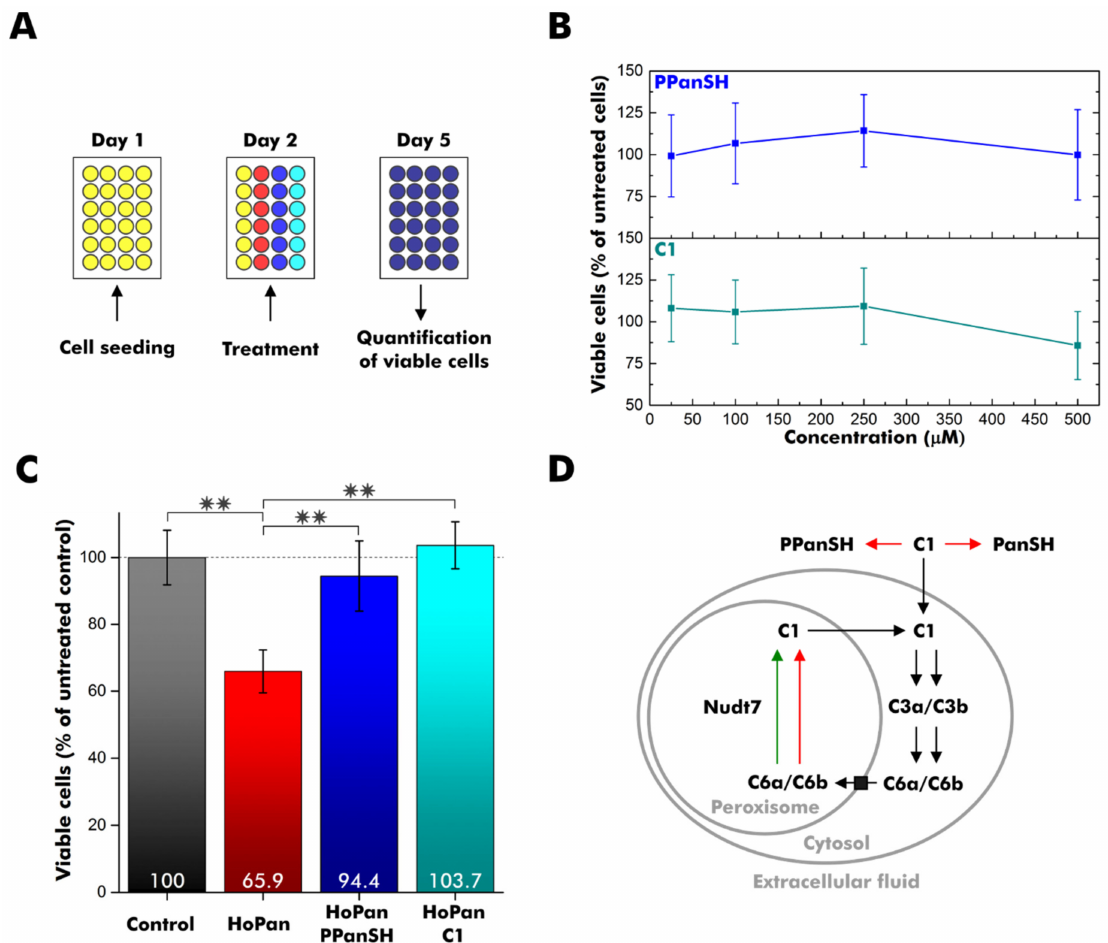
Figure 3. Supplementation of cell cultures with C1. ( A ) Experiment design overview. HEK 293T cells were seeded on day 1 and treated with calcium hopantenate (HoPan), PPanSH, C1, or a combination on day 2. Viable cells were quantified by a colorimetric cell proliferation assay on day 5. ( B ) Percentage of viable cells after growth in the presence of varying concentrations of PPanSH or C1 relative to untreated cells. ( C ) Percentage of viable cells after growth in the presence of 500 µ M HoPan, 500 µ M HoPan, and 25 µ M PPanSH, or 500 µ M HoPan and 25 µ M C1 relative to untreated cells (control). The statistical analysis was carried out by two-sample t -test (n = 6), and double asterisks (**) represent a p -value < 0.01. ( B , C ) Error bars represent the standard deviation (n = 6). ( D ) Simplified scheme for the intracellular fate of C1. Red arrows indicate non-conversion. The green arrow indicates conversion. Black arrows are still hypothetical. PanSH: